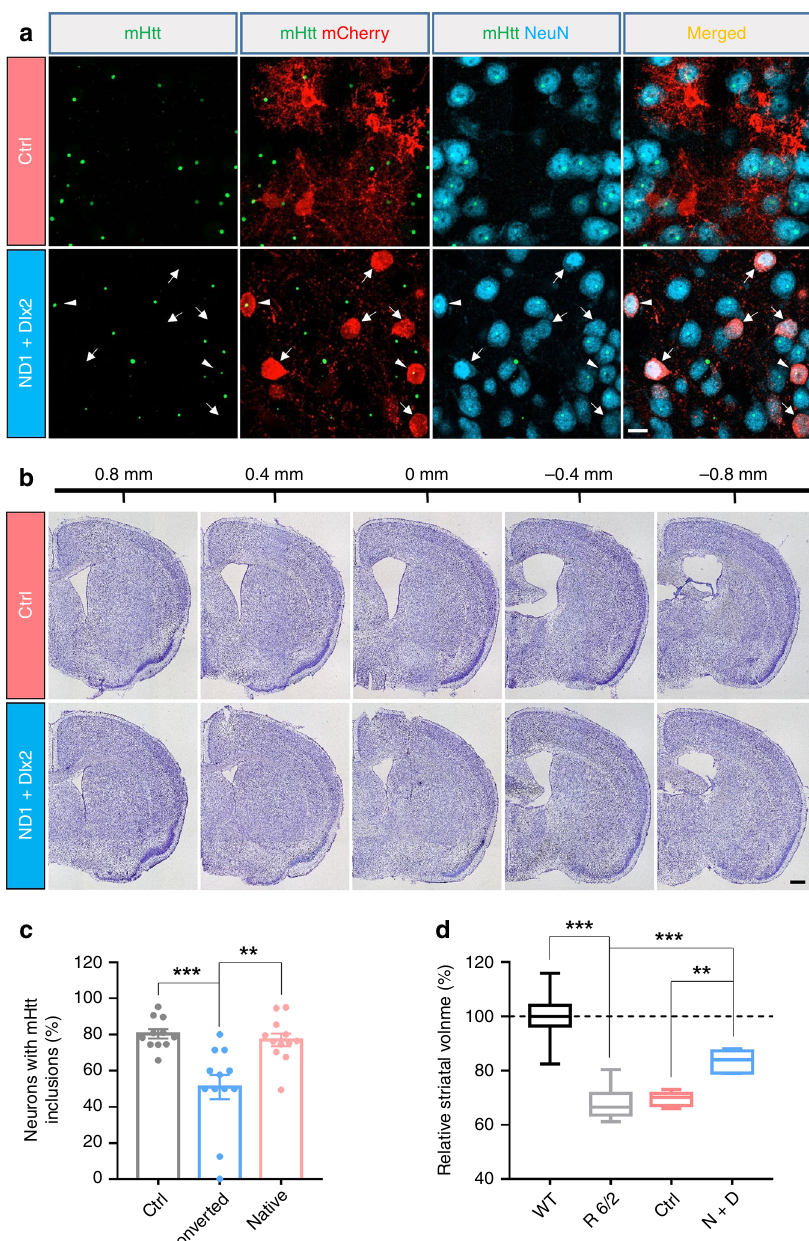
Fig. 7 Reducing striatum atrophy in the R6/2 mice after in vivo astrocyte-to-neuron conversion. a Reduction of mHtt inclusions in the striatal astrocyte- converted neurons in the R6/2 mice. The mHtt aggregates (green dots) were detected in most of the striatal neurons (NeuN, cyan), but some NeuroD1 plus Dlx2-converted neurons (red, pointed by arrows) showed no mHtt aggregates. Arrowheads indicate two converted neurons (mCherry + ) with mHtt inclusions. Scale bar: 10 µ m. b Assessing striatum atrophy by Nissl staining of serial coronal sections of the R6/2 mouse brain, treated with control mCherry virus alone (top row) or with NeuroD1 plus Dlx2 AAV (bottom row). Scale bar: 0.5 mm. c Quanti fi ed data showing that the percentage of neurons with mHtt inclusions in converted neurons was signi fi cantly lower compared with their neighboring native neurons or the striatal neurons in the control virus-treated group. Data are shown as mean ± SEM. d Summary graphs of the relative striatum volume (normalized to the WT) among R6/2 mice (P90 – 97), R6/2 mice treated with control viruses, and R6/2 mice treated with NeuroD1 plus Dlx2 viruses. Striatal atrophy was clearly detected in the R6/2 mice (P90 – 97), but partially rescued by NeuroD1 plus Dlx2 treatment. Data are shown as box plot (boxes, 25-75%; whiskers, 10-90%; lines, median). ** p < 0.01, *** p < 0.001, one-way ANOVA with Bonferroni ’ s post hoc another person decoded the mouse information. The Image J software was used for The images were acquired by a Zeiss confocal microscope (LSM 800). For quantifying the intensity of vGAT. quanti fi cation, 2 – 6 regions in the striatum were randomly selected for confocal imaging (×20 lens 2 – 4 regions; ×40 lens 4 – 6 regions). Most imaging analysis was performed with Zeiss software ZEN. In order to avoid the impact of human bias on the analysis, some of the mouse information was blinded during confocal imaging. Electrophysiology . Brain slices were prepared at 30 – 32 days after AAV injection, Moreover, image analysis was further performed blindly: the person who did the and cut to 300- μ m-thick coronal sections with a vibratome (Leica, VTS1200) at quanti fi cation did not know the injected virus information. After quanti fi cation,